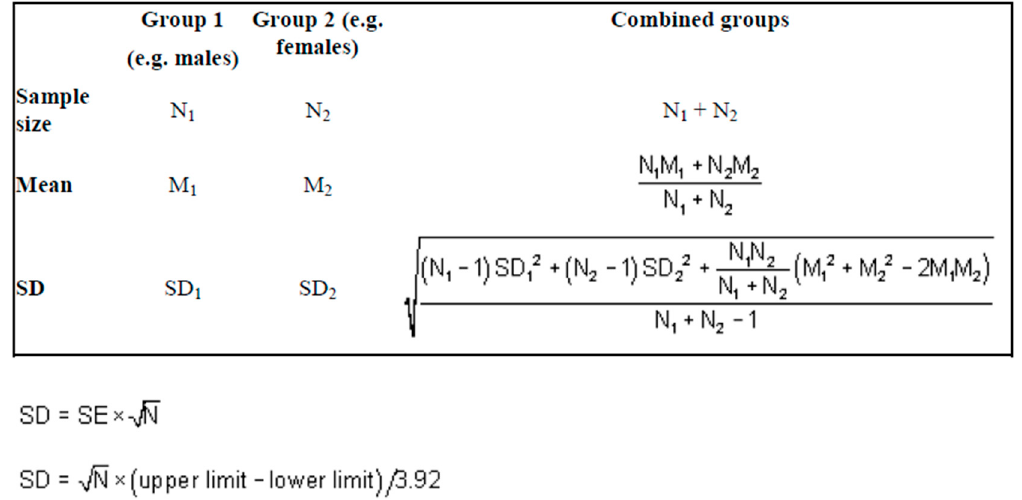
Figure 1. Statistical treatment.